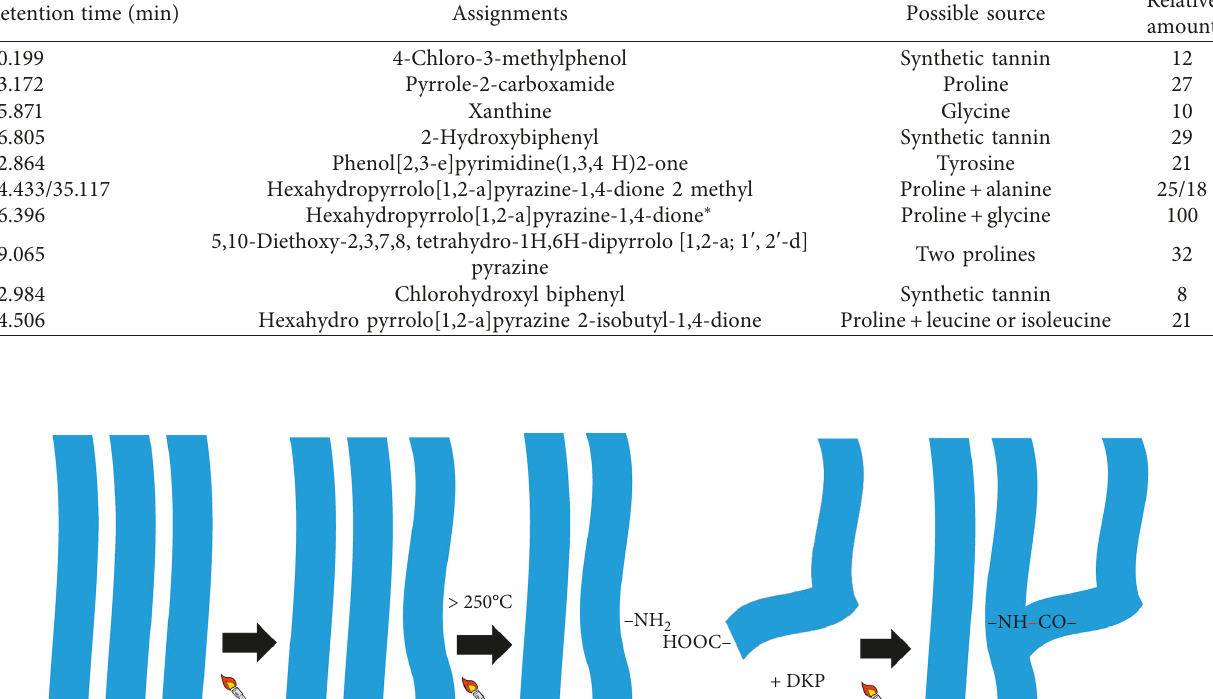
Table 1: Pyrolysis-GC-MS analysis at 330 ° C of wet-white leather shavings. Retention time